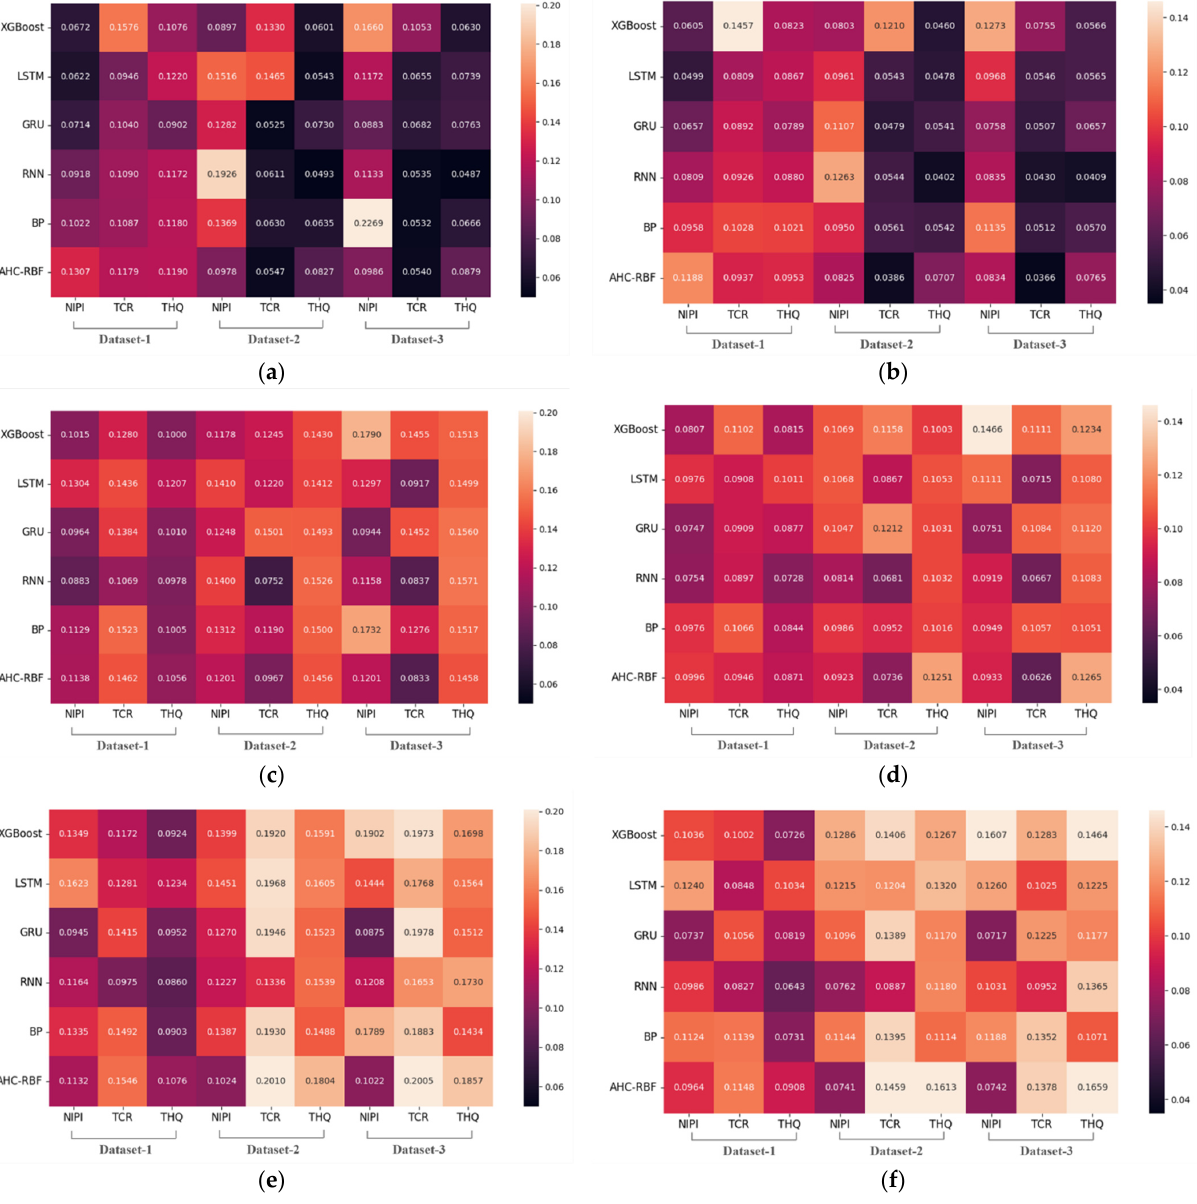
Figure 14. RMSE and MAE of the sub-models for the 7-, 14-, and 21-day predictions. ( a ) RMSE (7 days), ( b ) MAE (7 days), ( c ) RMSE (14 days), ( d ) MAE (14 days), ( e ) RMSE (21 days), ( f ) MAE (21 days).